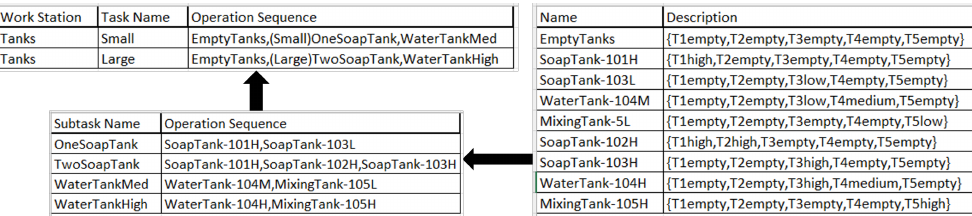
Figure 10. Tasks, Subtasks, and Shortcuts tables describing the Specification for the Plant of Figure